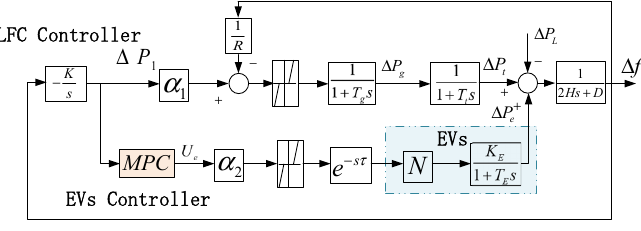
Figure 3. Primary electric vehicle frequency regulation control model.